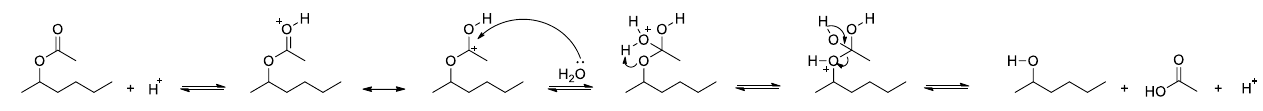
Figure 4. Total carboxylic acid content vs [H 3 O + ] (the pH is given for information) at different γ-doses. The total carboxylic acid content is the sum of all the acid concentrations detected by ion chromatography. The dashed line shows the trend. Reproduced from [32] with the permission of European Journal of Pharmaceutical Sciences.